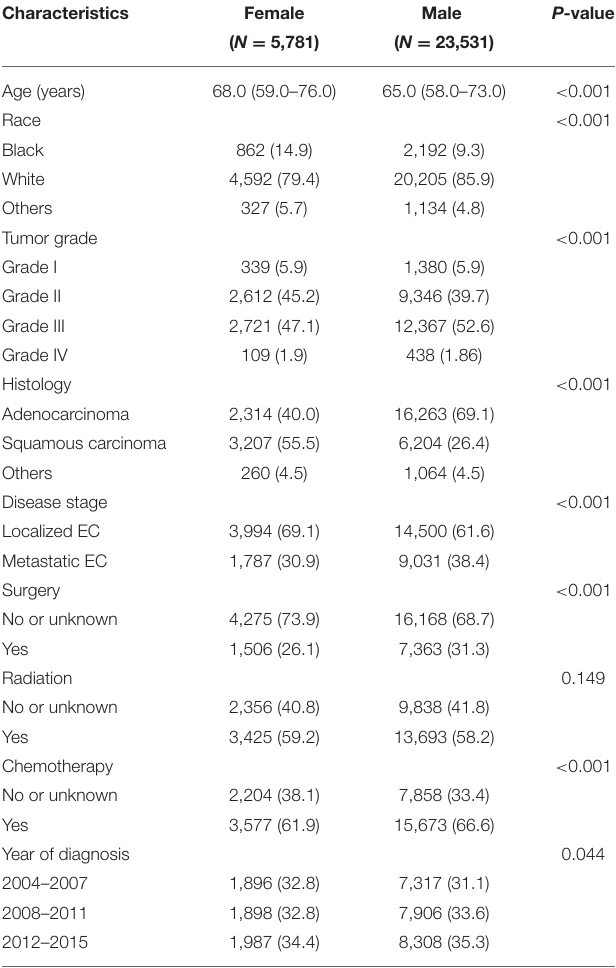
TABLE 1 | Patient characteristics stratified by sex.